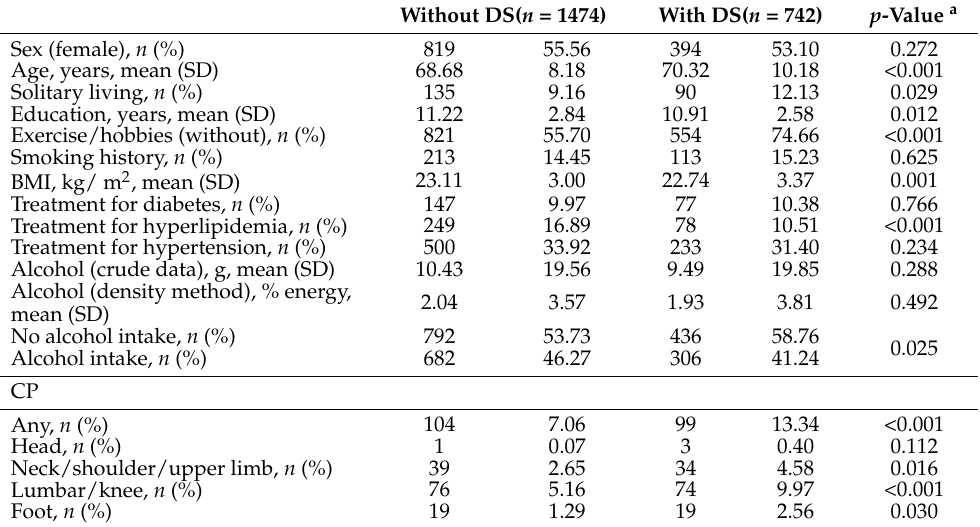
Table 2. Characteristics of hypertension and GDS according to sex.